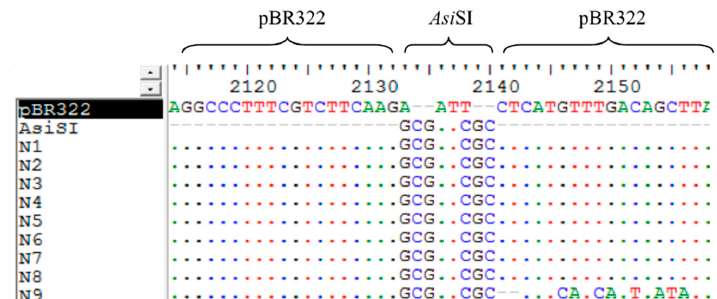
Figure 8. Alignment of the sequences of nine false positive clones with pBR322. The homologous Asi SI sequences (GCGATCGC) were recombined into all the false positive clones, while the 40 bp ITR overlapping sequence was deleted. The letters in different color represent the four nucleotides: A in green, T in red, G in black, and C in blue. The dots indicate identical nucleotides.